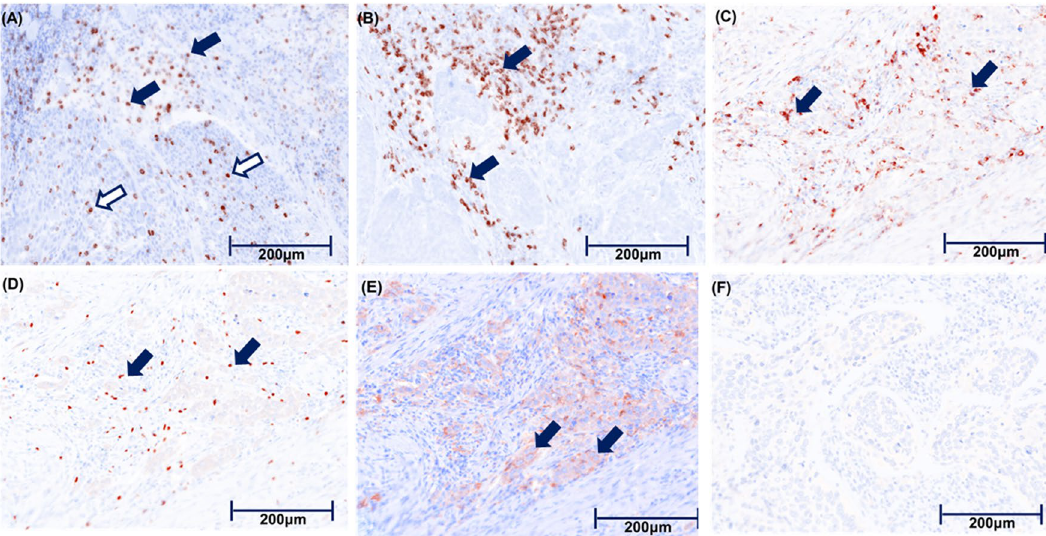
Figure 1. Representative pathological view of immunohistochemistry. ( A ) tumoral (white arrow) and stromal (black arrow) CD8 + TIL. ( B ) stromal CD8 + TIL (black arrow). ( C ) stromal CD4 + TIL (black arrow). ( D ) stromalFoxP3 + TIL (black arrow). FoxP3 − CD4 + Tcell was calculated by excluding CD4 + FoxP3 + Tcell from CD4 + TCell. ( E ) PD-L1 positive case. High PD-L1 expression in tumor cells (black arrow). ( F ) PD-L1 negative